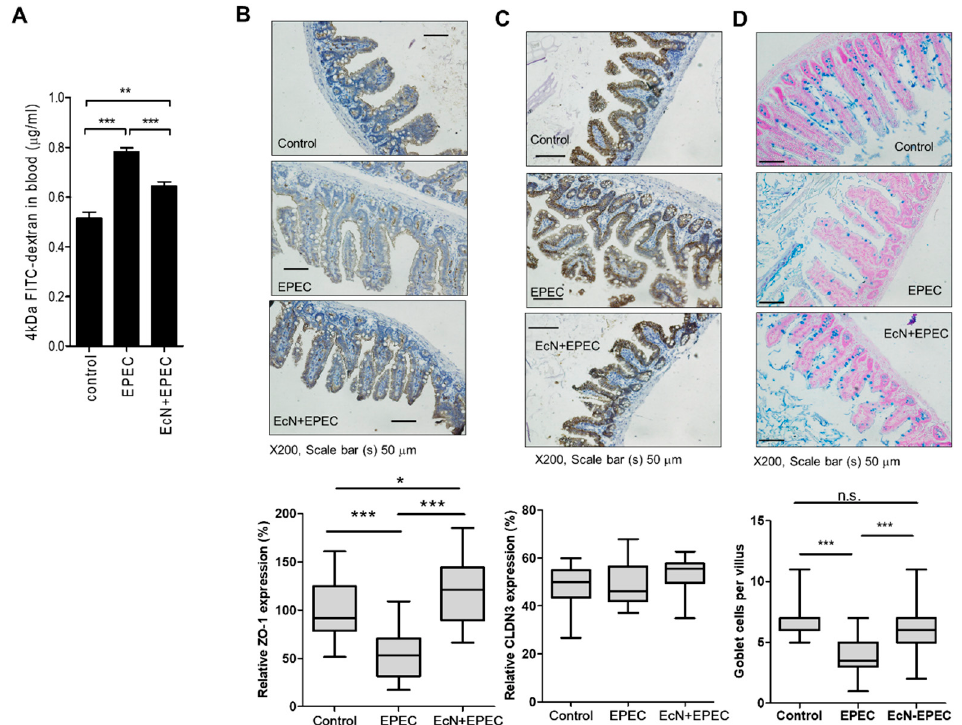
Figure 3. E ff ect of EcN on gut barrier integrity in EPEC-infected mice. Mice pretreated with EcN (2 × 10 9 cfu (colony-forming unit) per mouse) were exposed in EPEC-infected mice. ( A ) Serum FITC-dextran levels. ( B , C ) Expression of tight junction (TJ) molecules in the colon of mice with colitis. ZO-1 (B) or claudin-3 (C, CLDN3) were analyzed with immunohistochemistry analyses in the colon at day 10 (original magnification × 200; scale bar(s), 50 µ m). ( D ) The sections were stained with Alcian blue for the analysis of goblet cells and mucin production (original magnification × 200; scale bar(s), 50 µ m). Lower graphs indicate the quantitation of each staining using the HistoQuest analysis software. Asterisks represent significant di ff erences between the groups (* p < 0.05, ** p < 0.01, *** p <